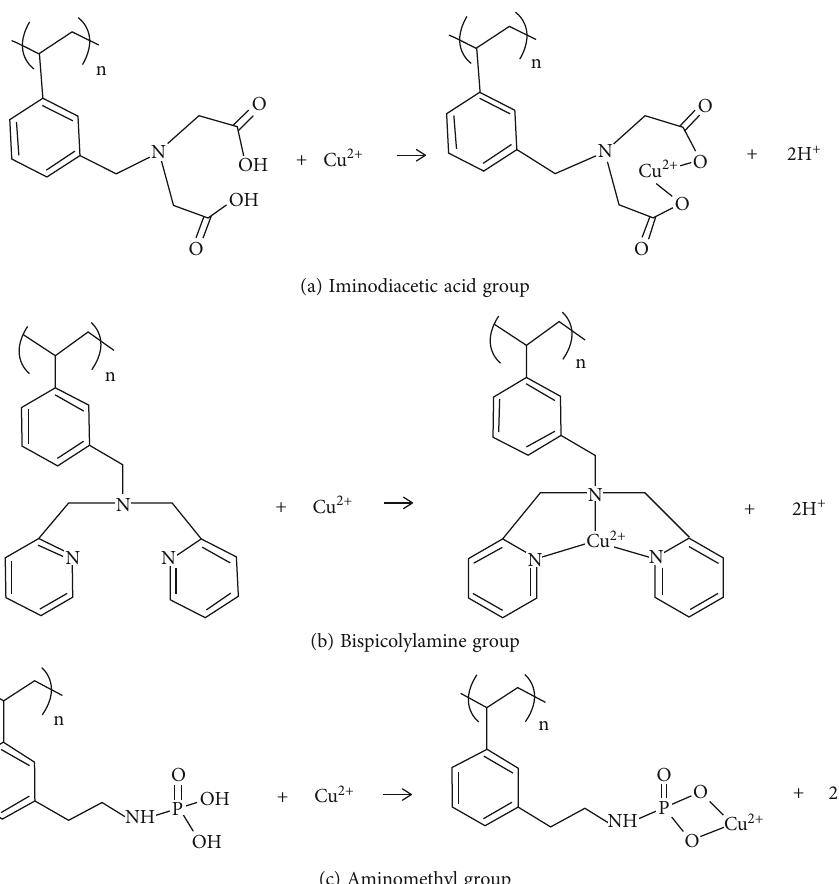
Figure 1: Possible sorption process reaction of copper (II) ion removal onto iminodiacetic acid (a), bispicolylamine (b), and aminomethyl (c) groups in the acidic solutions.